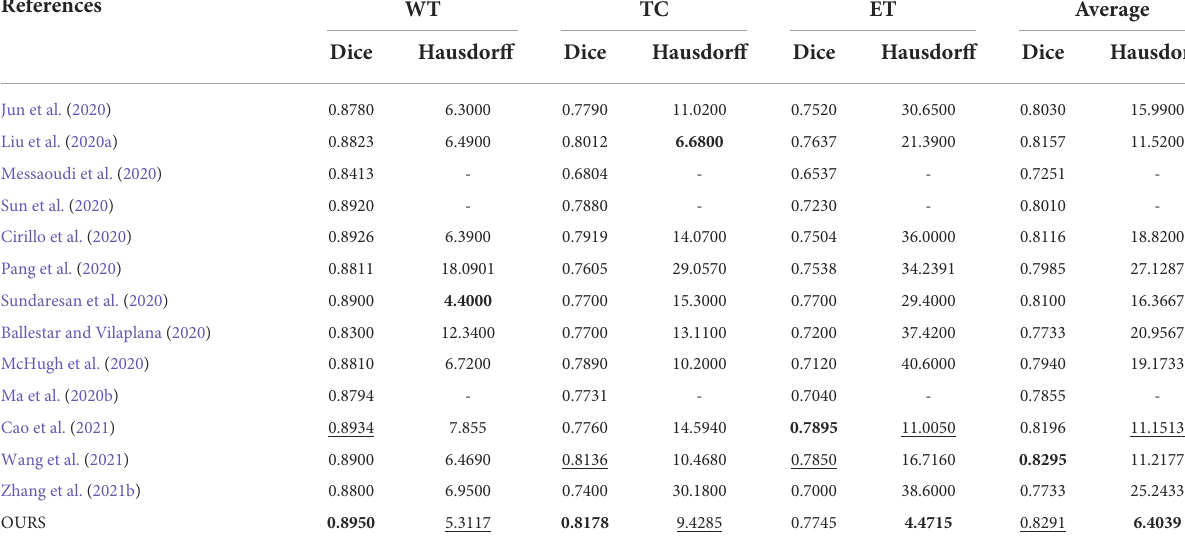
TABLE 5 Objective evaluation results of different brain tumor segmentation methods on the BraTS 2020 validation